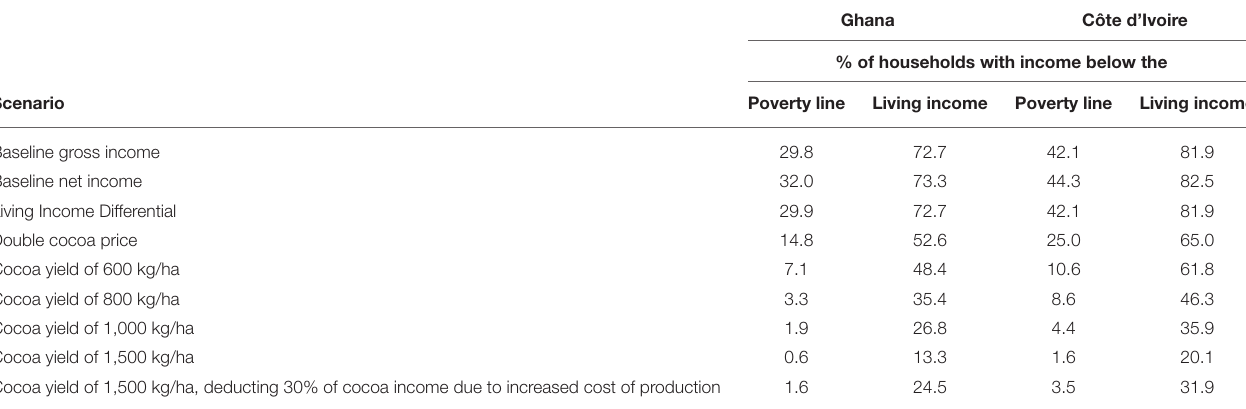
TABLE 4 | Impacts of all scenarios related to increasing cocoa productivity or increasing the price farmers receive for their cocoa on the proportion of cocoa farmers who achieve an income equivalent to the World Bank extreme poverty line or the Living Income benchmark for Ghana of Smith and Sarpong (2018) and for Côte d’Ivoire of CIRES (2018).